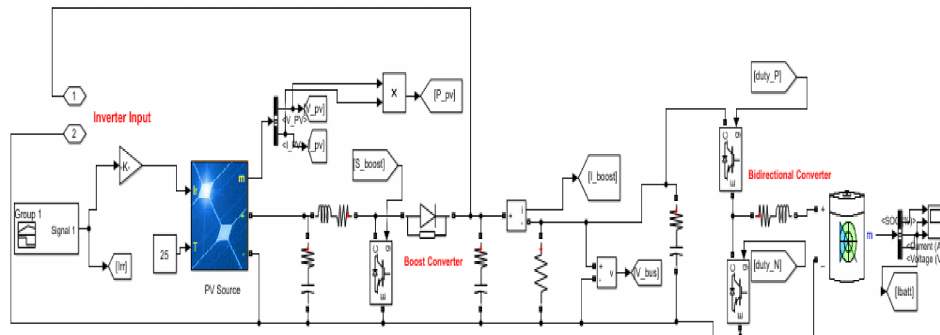
Figure 9. EV Charging station.